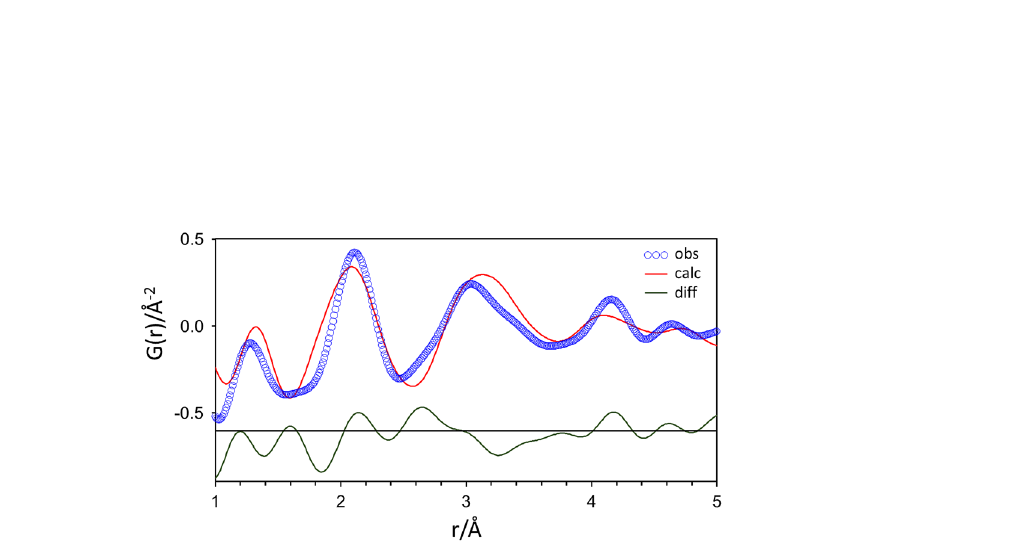
Figure 4. PDF fit of AMC20 between 1 and 5 Å with hydromagnesite structure 10